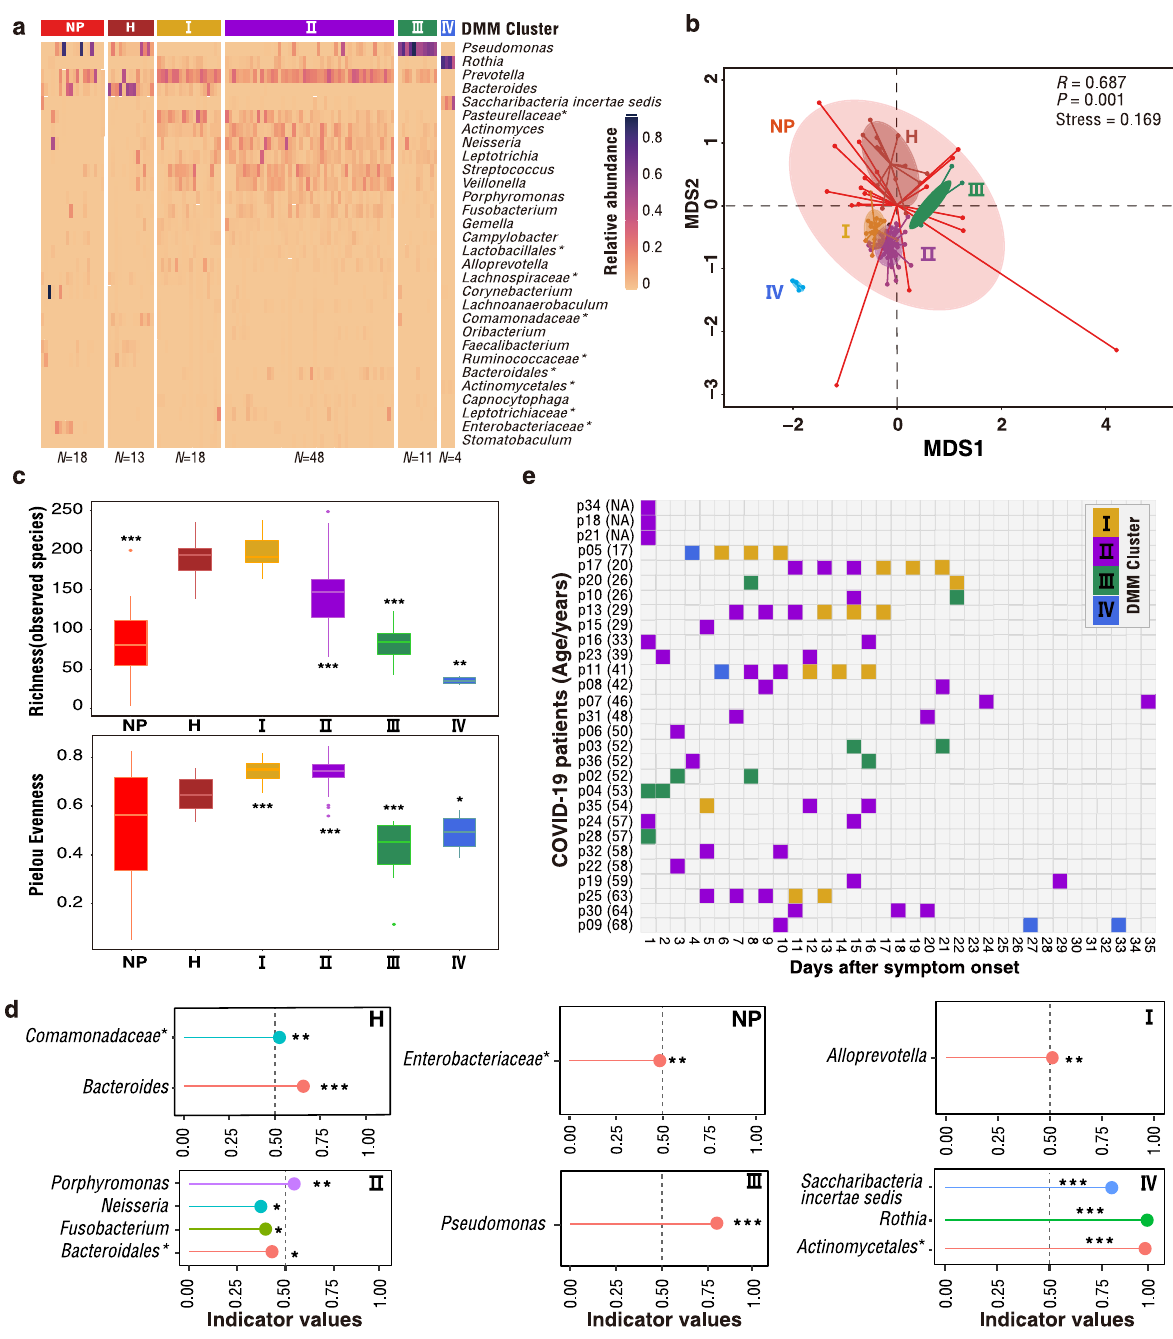
Fig. 1 DMM clustering of 16 S rRNA gene-sequencing data of throat microbiota ( N = 112). Dirichlet multinomial mixtures (DMM) modelling was applied to 16 S rRNA gene sequencing. The entire dataset formed six distinct clusters based on lowest Laplace approximation. Bacterial taxa marked by the stars represent unclassi fi ed bacteria genera. a Heatmap showing the relative abundance of the 30 most dominant bacterial genera per DMM cluster. The stars represent unclassi fi ed genera. NP, enriched in Non-COVID-19 patients. H, enriched in Healthy individuals. I – IV enriched in COVID-19 patients. b Nonmetric multidimensional scaling (NMDS) visualization of DMM clusters using Bray – Curtis distance of throat bacterial genera. The ANOSIM statistic R closer to 1 with <0.05 P- value suggest signi fi cant separation of microbial community structures. The stress value that was lower than 0.2 provides a good representation in reduced dimensions. c Boxplots showing the alpha-diversity (richness and evenness) per each DMM cluster. d Indicators of airway microbial community types (DMM clusters) identi fi ed from top 30 genus contributing to throat microbial community typing (DMM clustering) in a . The length of lines represents the indicator value. * P < 0.05, ** P < 0.01, and *** P < 0.001. e Dynamic shift of four throat microbial community types (DMM clusters) in different COVID-19 stages. Empty boxes indicate samples were unavailable in COVID-19 patients. Ages (years) were shown in parenthesis. NA unavailable.